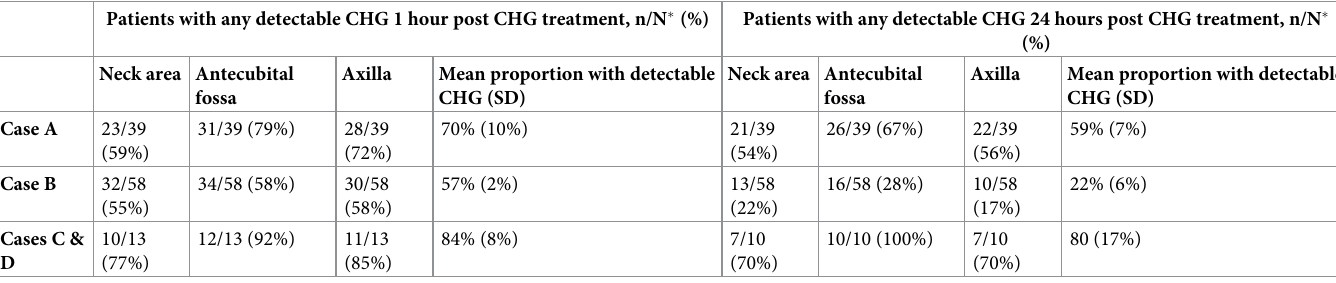
Table 3. Proportion of patients with ANY detectable CHG concentration post-CHG treatment. Patients with any detectable CHG 1 hour post CHG treatment, n/N �